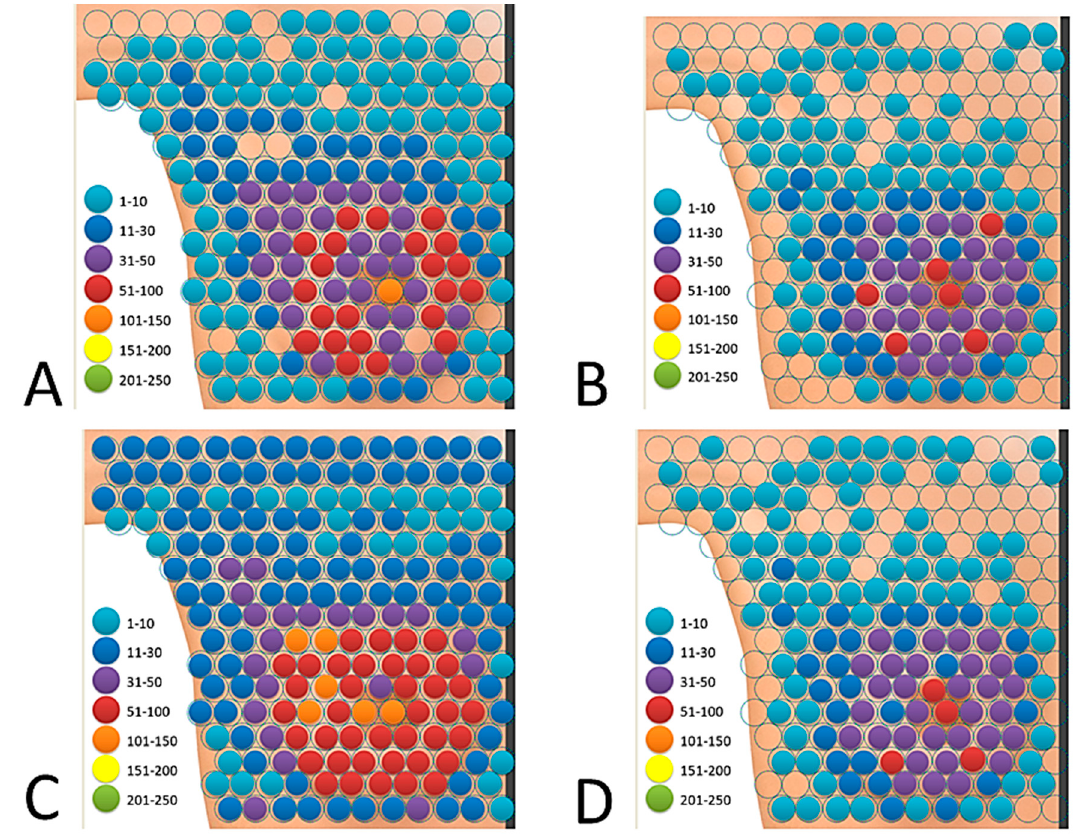
Figure 6. In the proprietary interactive tactile test “breast self-examination”, the distribution of the total marked area of the breast by all users in both groups: ( A ) the study group—Test I, ( B ) the control group—Test I, ( C ) the study group—Test II and ( D ) the control group—Test II. Table 5. In the proprietary interactive tactile test “breast self-examination”, the amount of marked area—Test I. Marked Area (Number of Not Marked Area Points) (Number of Points) N % N % Study group 178 89.0